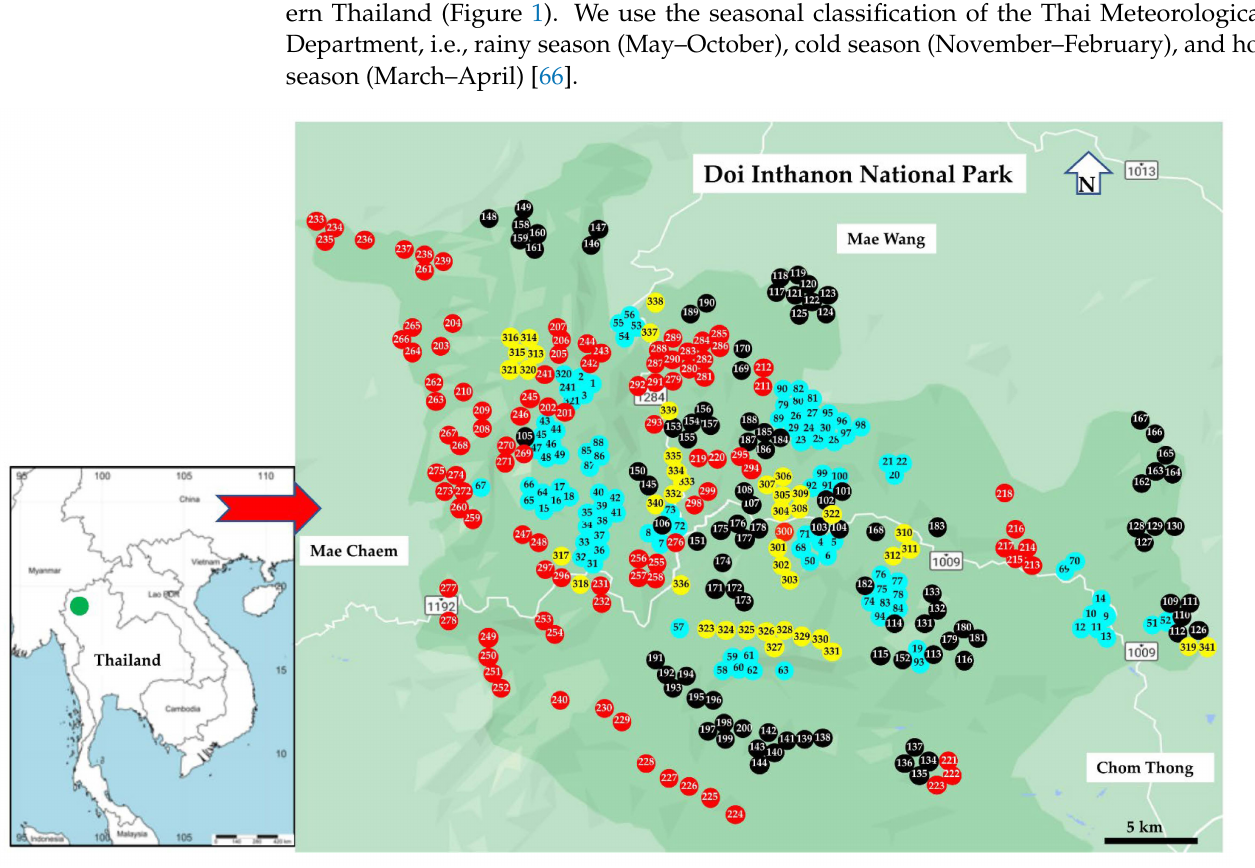
Figure 1. Map of Thailand showing the study area (http://www.simplemappr.net, accessed on 20 July 2022) and collection sites in Doi Inthanon National Park; numbers in circles indicate collection numbers (Table S1); blue, 1–100; black, 101–200; red, 201–300; and yellow,